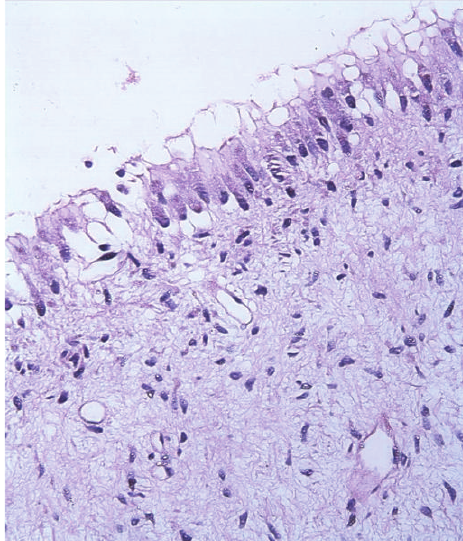
Figure 3: Mucous cell proplasia and f ı bromyxoid type connective tissue (HE × 100).